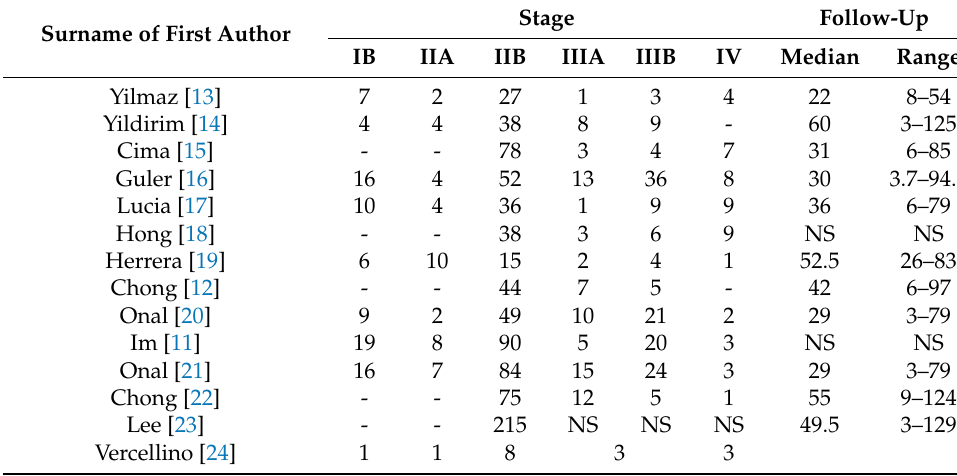
Table 2. Disease features: stage and